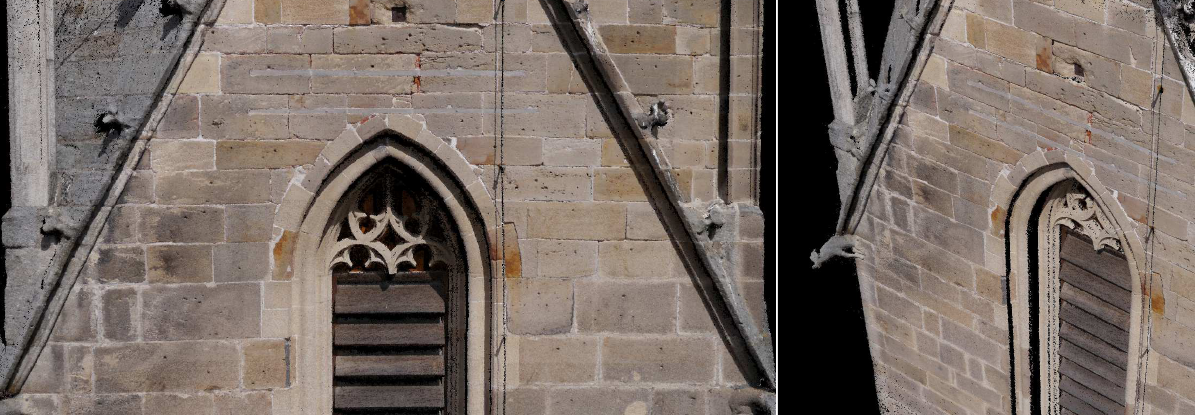
Fig. 4.4: Resulting point cloud after stereo models selection and dense image matching with SURE (filtered with maximum occurence 1). Full cloud (84 Mio. pts.), filtered with mo 1 (13 Mio. pts.), filtered with mo 2 (5 Mio. pts.), filtered with mo 4 (2.4 Mio.